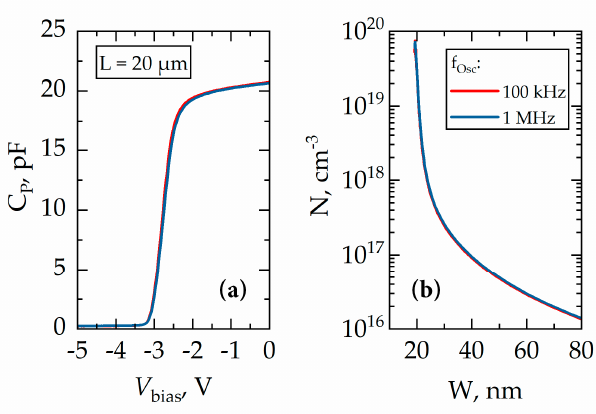
Figure 5. ( a ) Capacitance-voltage ( C - V ) characteristics of SBD with L = 20 µ m at modulation frequencies of 100 kHz (red line) and 1 MHz (blue line), and ( b ) carrier distribution N(W) calculated from C - V data using Equations (2) and (3).